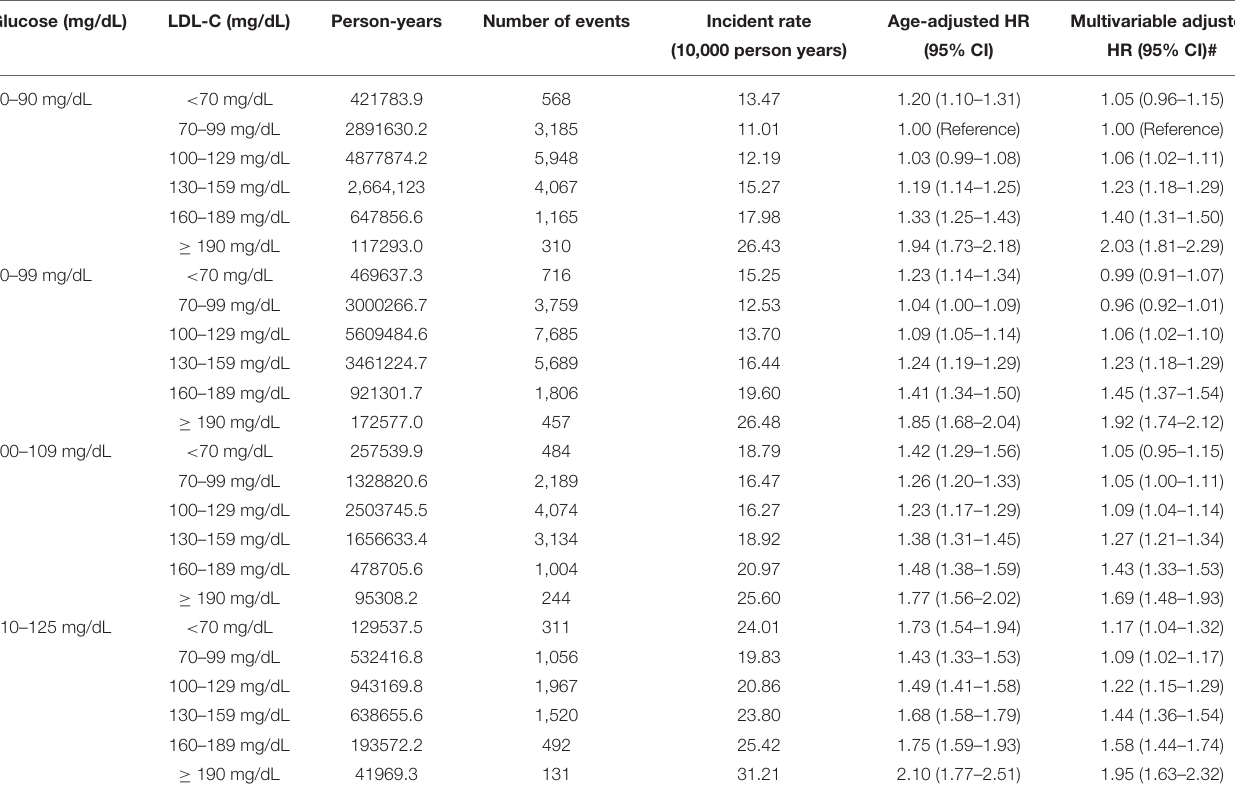
TABLE 3 | Risk of primary outcome according to the baseline LDL-C levels excluding subjects who died within 2 years of follow-up stratified by fasting glucose level at baseline. Glucose